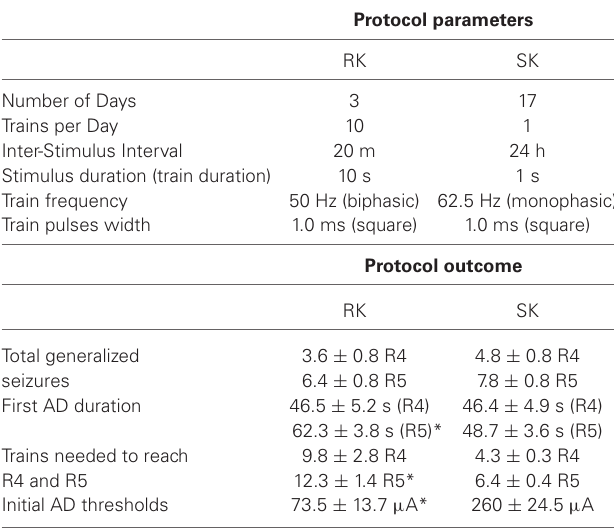
Table 1 | Protocol parameters and outcome comparison between RK and SK.